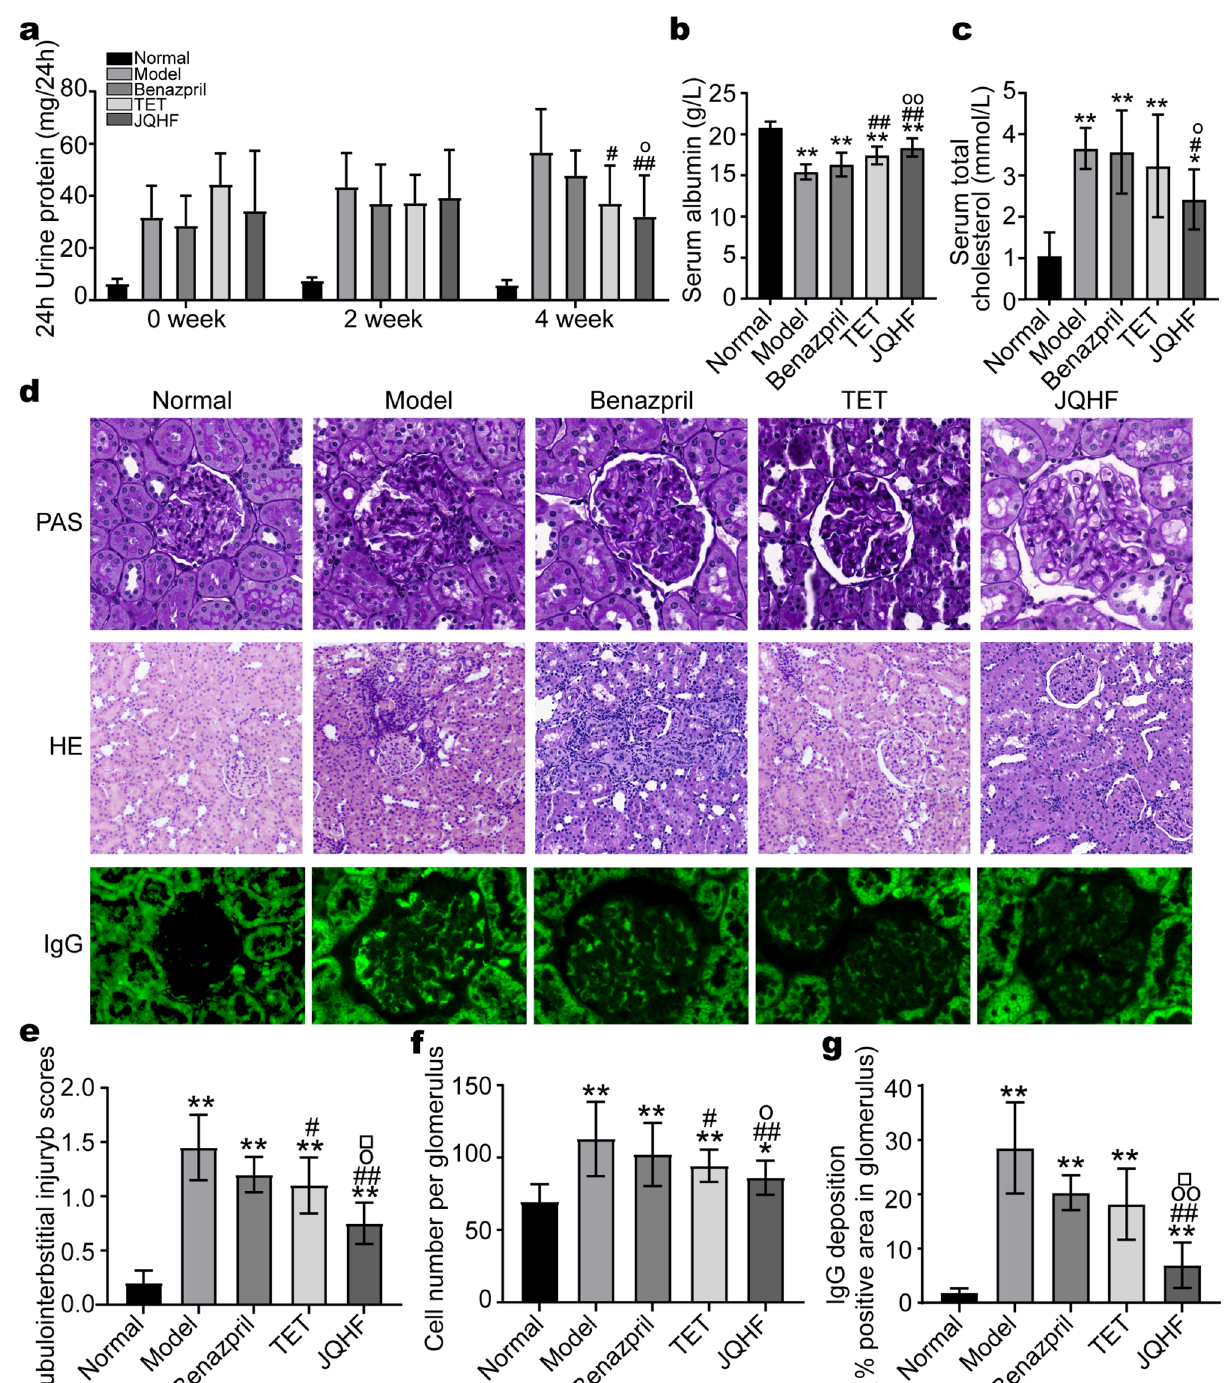
Figure 1. Effects of JQHF on biochemical parameters and renal pathology in PHN rats. ( a ) 24 h urinary protein. ( b ) ALB. ( c ) TC. ( d ) Representative microstructural images of diferent groups. (HE staining original magnifcation × 100: PAS and IgG staining, original magnifcation × 400). ( e ) Tubulointerstitial injury scores, ( f ) Glomerular hypercellularity. ( g ) The positive area of IgG deposition in glomerulus. Data were analysed by one-way ANOVA followed by post hoc LSD test ( a – c , e – g ) and presented as the mean ± SD (n = 6). *P < 0.05 vs. Normal group, **P < 0.01 vs. Normal group, # P < 0.05 vs. Model group, ## P < 0.01 vs. Model group, ○ P < 0.05 vs. Benazepril group and ○○ P < 0.01 vs. Benazepril